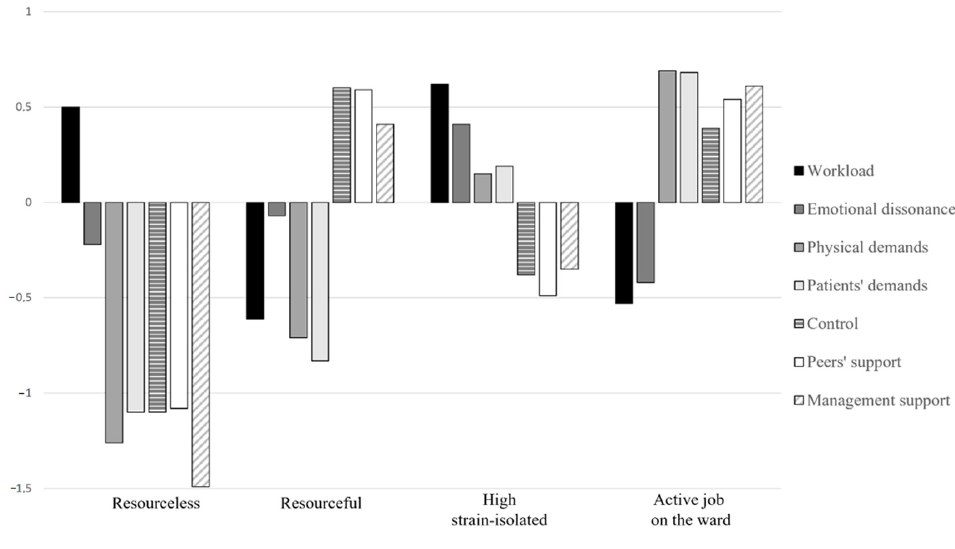
Figure 1. Elbow plot for the information criteria. Note. The number of profiles extracted in an LPA model are on the X-axis and the fit statistics are on the Y-axis.